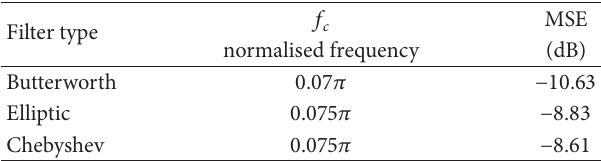
Table 1: Best cut-off frequency 𝑓 𝑐 and corresponding MSE to the matched filter’s magnitude’s response.